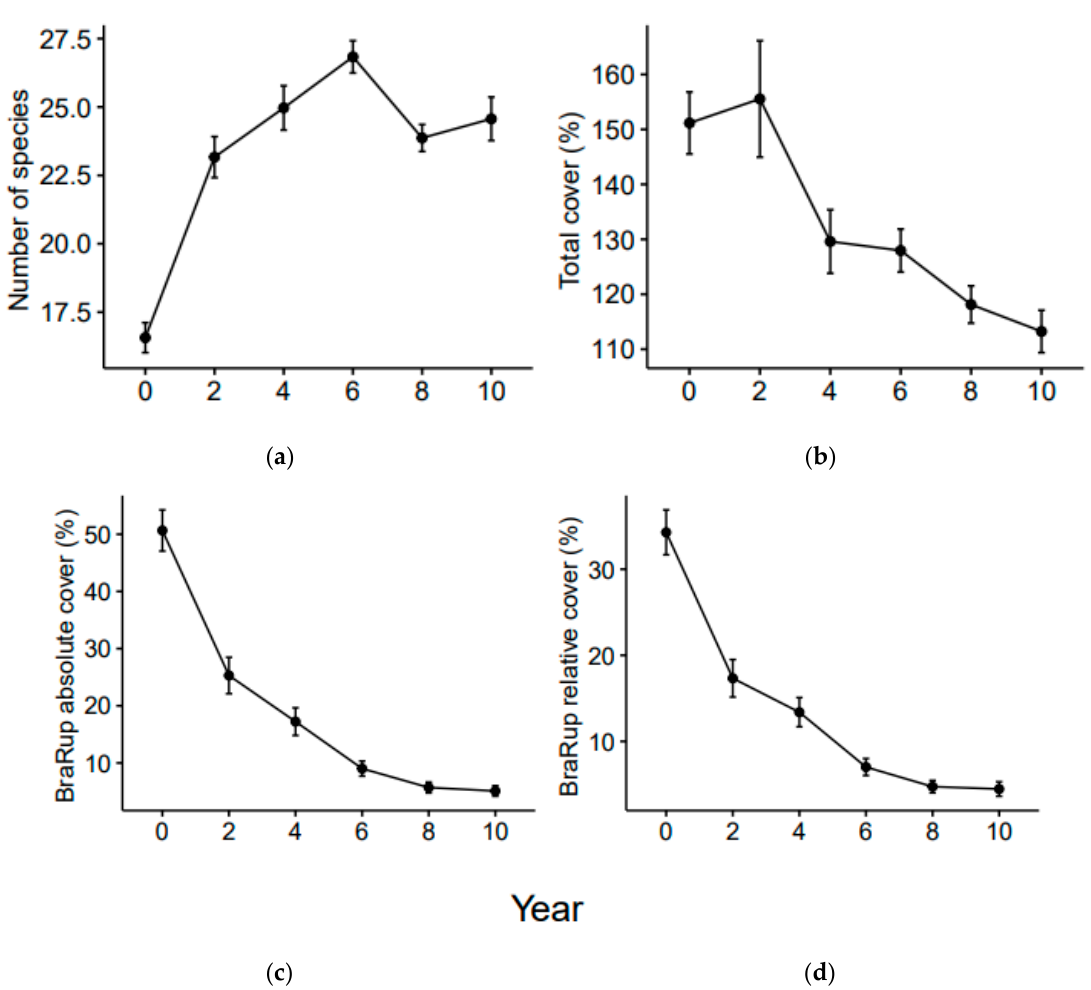
Figure 1. Variation (mean ± s.e.) of ( a ) number of species, ( b ) total cover percentage, ( c ) Brachypodium rupestre absolute percentage cover, and ( d ) B. rupestre relative percentage cover during the treatment. Year 0 (before treatment) refers to 2010; years 2, 4, 6, 8, and 10 correspond to 2012, 2014, 2016, 2018, and 2020. Table 2. Trends of standardized effect size of functional diversity under twice-a-year mowing of plant height (H), horizontal architecture (HA), specific leaf area (SLA), leaf dry matter content (LDMC), leaf area (LA), leaf phenology (LP), flower phenology (FP), clonal spread (CS), clonal position (CP), and Grime’s CSR strategies. Significant relations ( p -value < 0.05) are indicated in bold. AIC values are referred to REML (restricted maximum likelihood). Effective degrees of freedom (edf) are a measure of the shape of the curves (with 1 completely linear; 2 completely quadratic; 3 completely cubic).